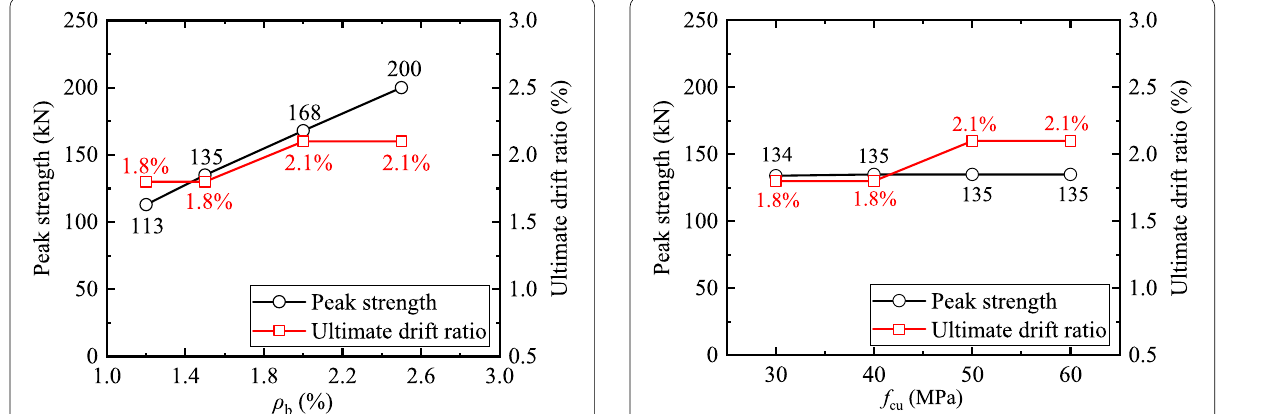
Fig. 21 Peak strength and ultimate drift ratio of specimens versus boundary longitudinal reinforcement ratio.